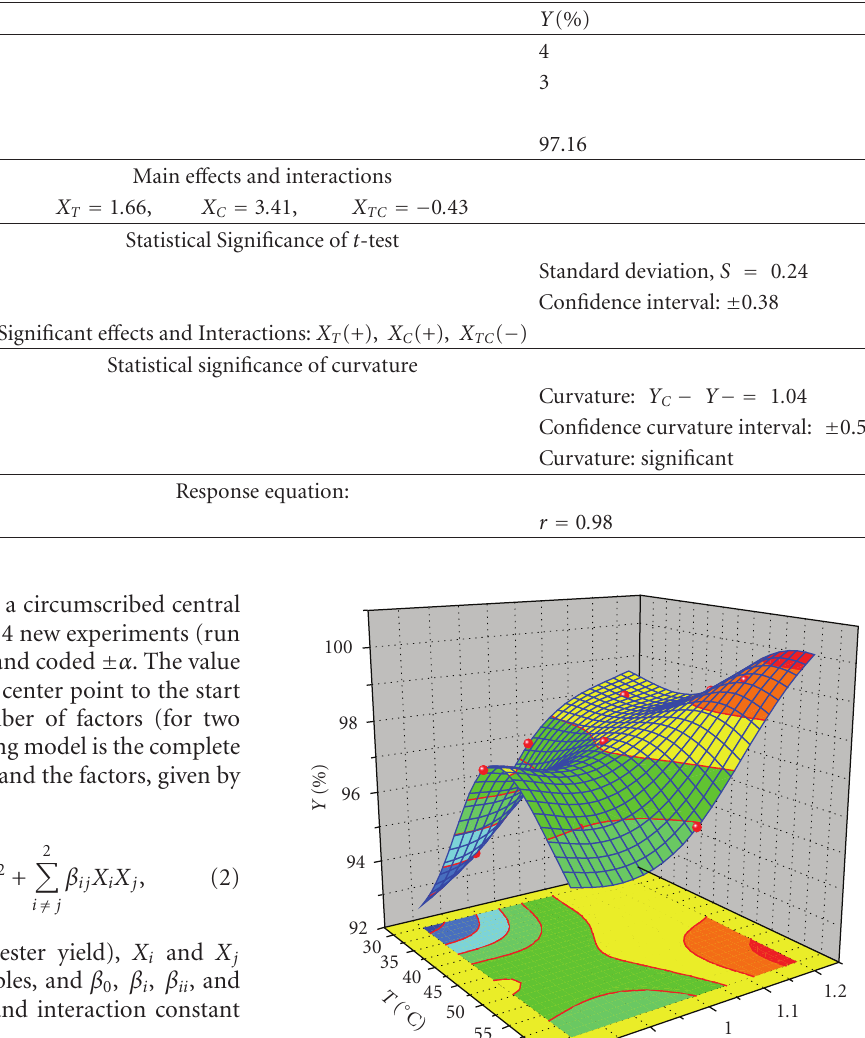
Table 3: 2 2 factorial design: statistical analysis.